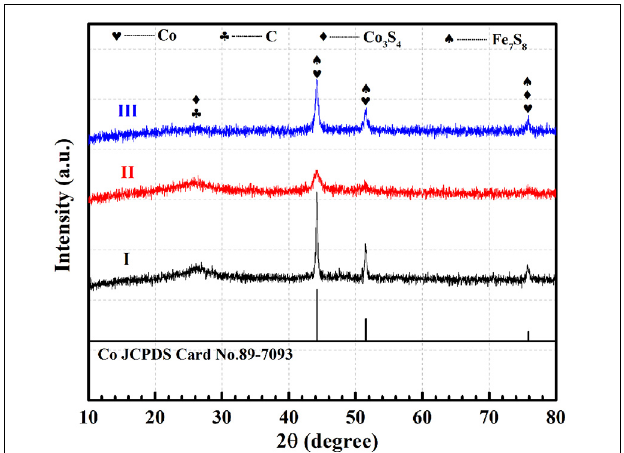
FIGURE 4 | X-ray diffraction spectrum of the Zn/Co/Fe–S–NC-900(I), Zn/Co/Fe–NC-900(II), and